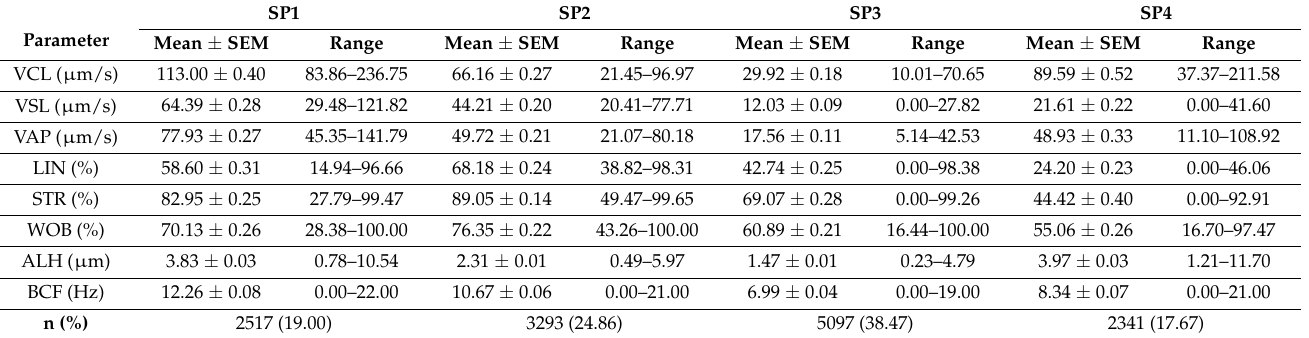
error of the mean; n: number of spermatozoa; %: percentage of subpopulation.